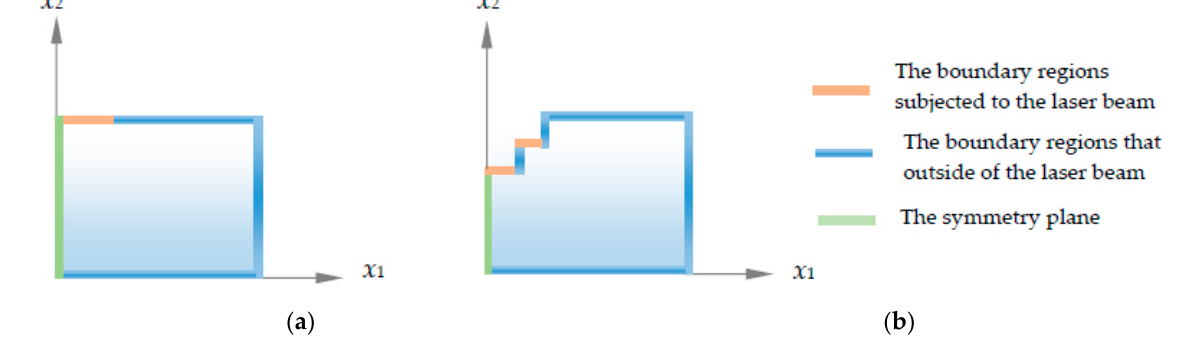
Figure 1. The solution domain: ( a ) The initial solution domain; ( b ) the solution domain during laser drilling process.